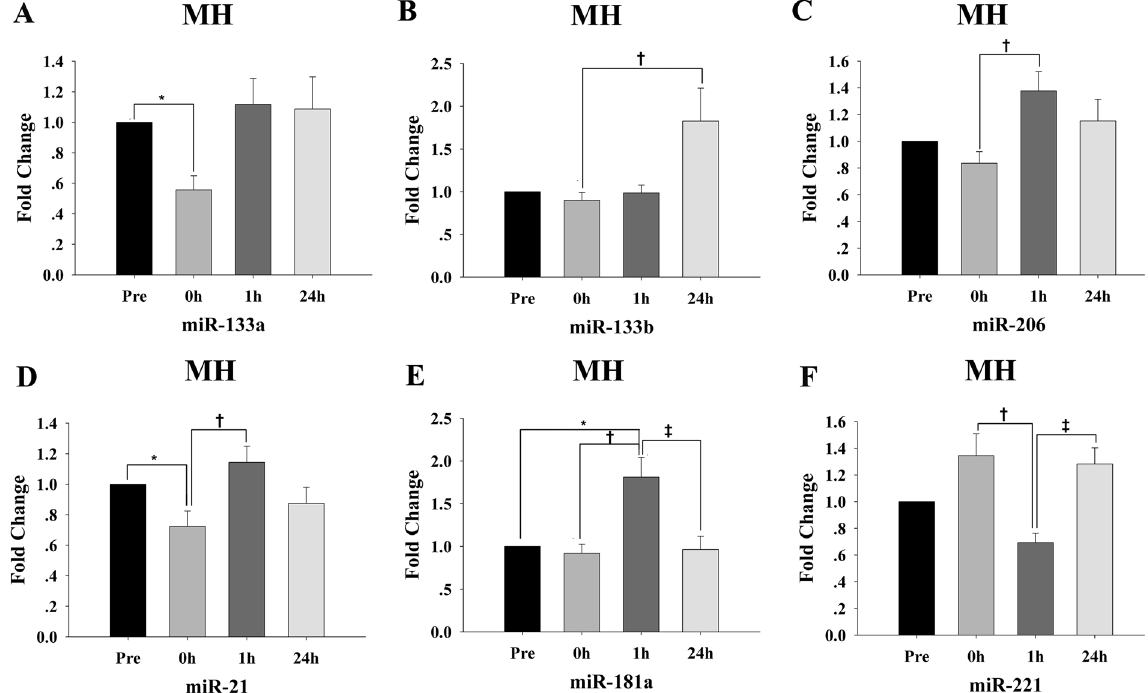
Figure 5. Time-course changes in specific circulating miRNAs for the muscle hypertrophy (MH) protocol (n = 15). ( A–F ) For each participant, the c-miRNA levels at baseline (Pre) were assigned a fold change of 1, and measurements obtained immediately after exercise (0 h), after 1 h of recovery (1 h) and after 24 h of recovery (24 h) were compared to the baseline. * indicates differences compared to Pre, p < 0.05; † indicates differences compared to 0 h, p < 0.05; ‡ indicates differences compared to 1 h, p < 0.05. Values represent the mean ±